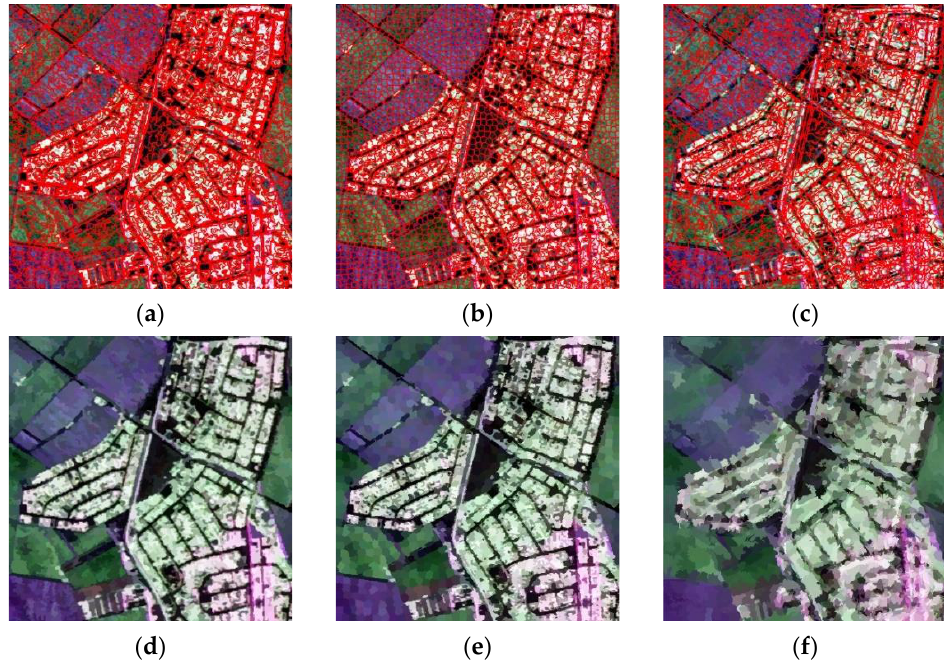
Figure 8. Segmentation results of AIRSAR data using the proposed method, the Pol-SLIC, and Pol-ERM. The first row of images ( a – c ) shows the edges of superpixels. The second row of images ( d – f ) shows the superpixel results with its covariance matrix averaged.